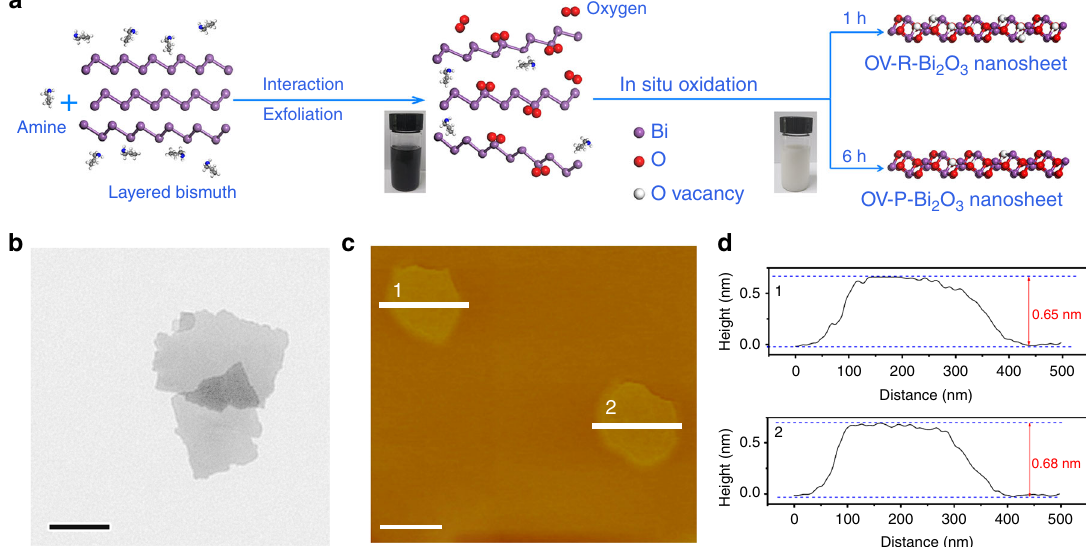
Fig. 2 Synthesis and morphology study. a Schematic introduction for the preparation of ultrathin Bi 2 O 3 nanosheets with rich/poor oxygen vacancies. b TEM image of the OV-rich-Bi 2 O 3 nanosheets. c , d AFM image and the height distributions (close to the regions of Line 1 and 2) of the OV-rich-Bi 2 O 3 nanosheets, respectively. The scale bars in ( b , c ) are 200 nm